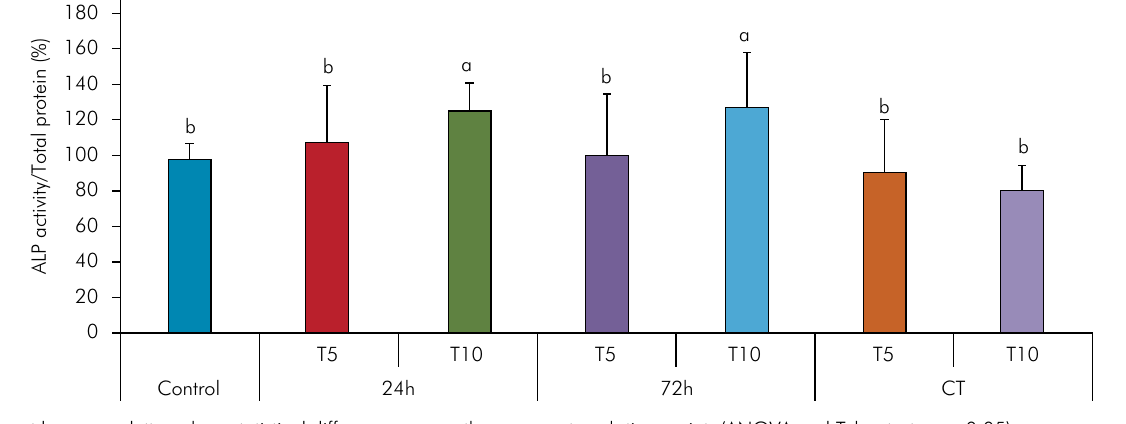
Figure 3. Alkaline phosphatase activity (means/standard deviations) after 6 days of treatment with taxifolin at 5 and 10 µM for 24h, 72h and continuous treatment (CT). Control: DMEM with 10 µM DMSO.